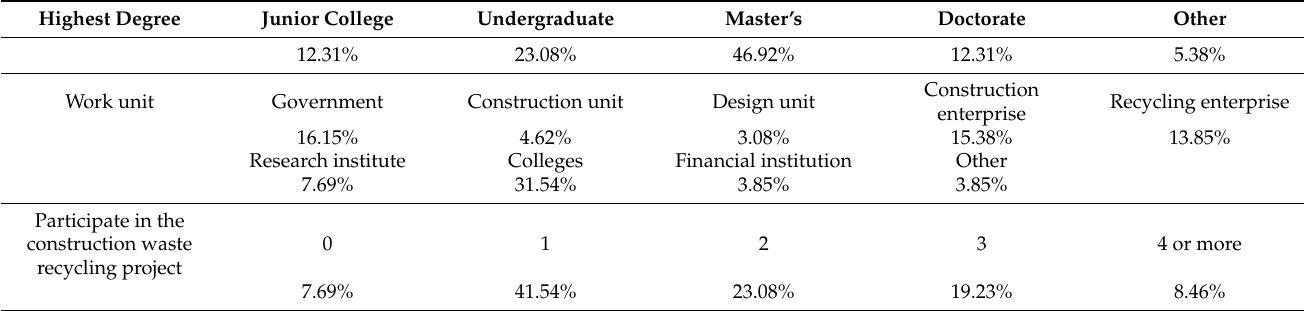
Table 1. Basic information of interviewees.